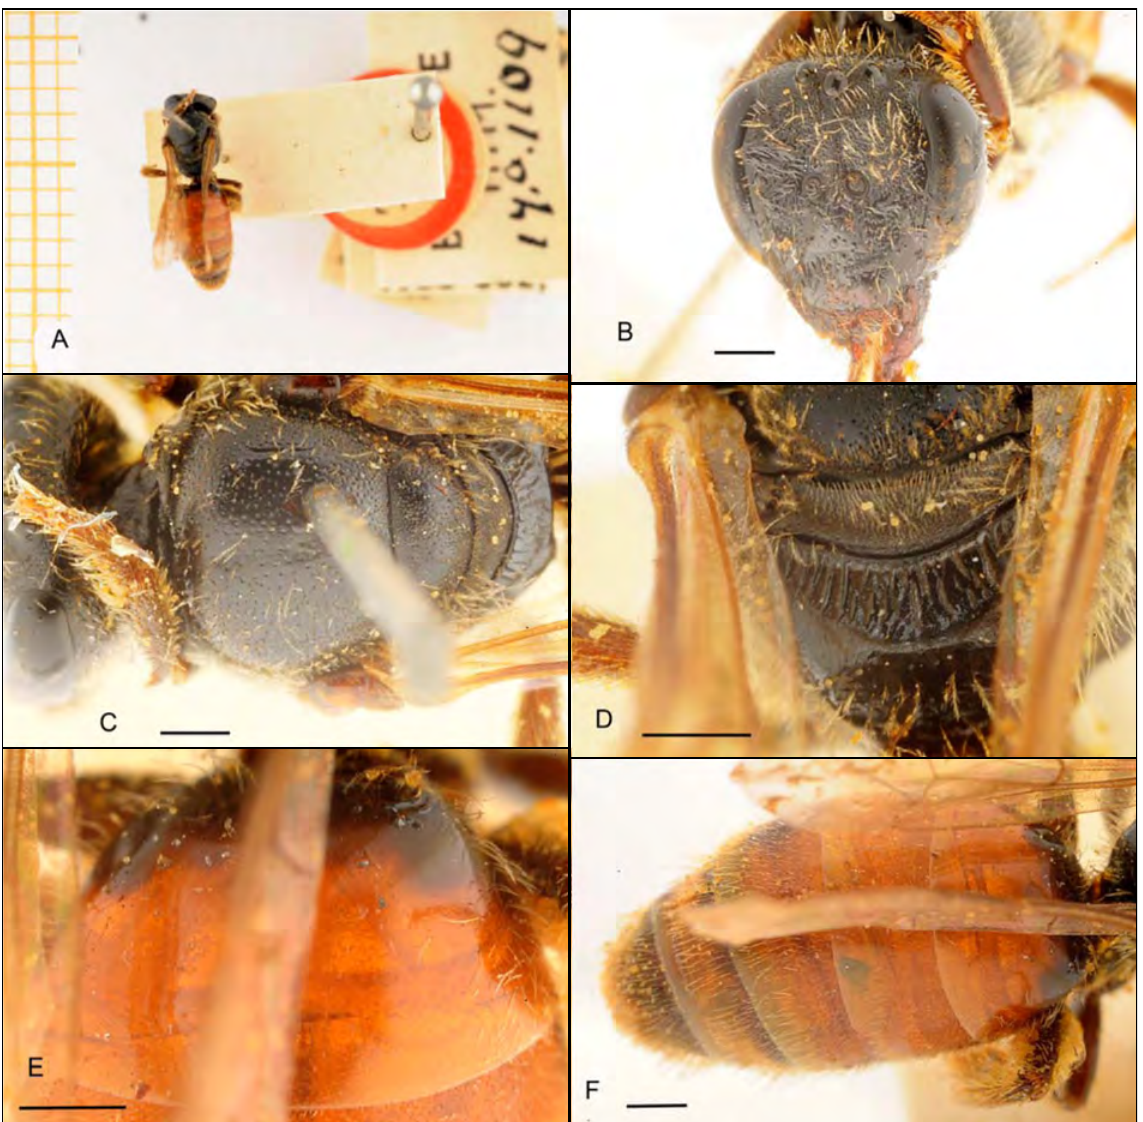
Fig. 2. Lasioglossum ( Capalictus ) mosselinum (Cockerell, 1945), ♀ holotype. A . Total view. B . Head. C . Mesosoma. D . Propodeum. E . First tergum. F . Metasoma. Scale line = 0,5